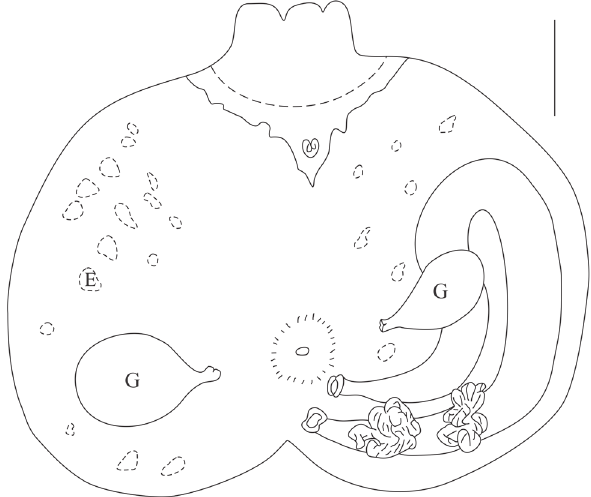
Figure 2. Microcosmus anchylodeirus , dissected individual without pharynx. (G) Gonad, (E) endocarp. Scale bar: 1.0